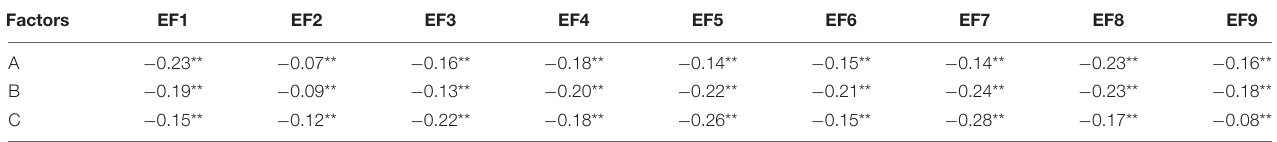
TABLE 5 | Correlation between EOCL-1 and prefrontal symptoms. Factors